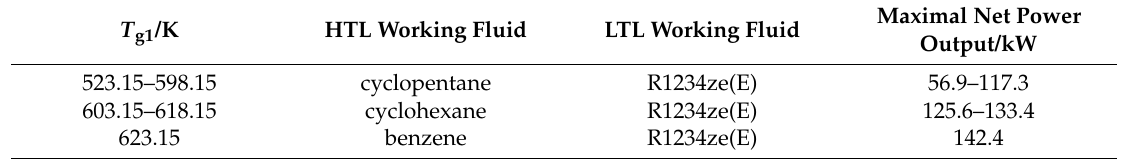
Table 7. Optimal working fluids and net power output with T g1 of 523.15–623.15 K.